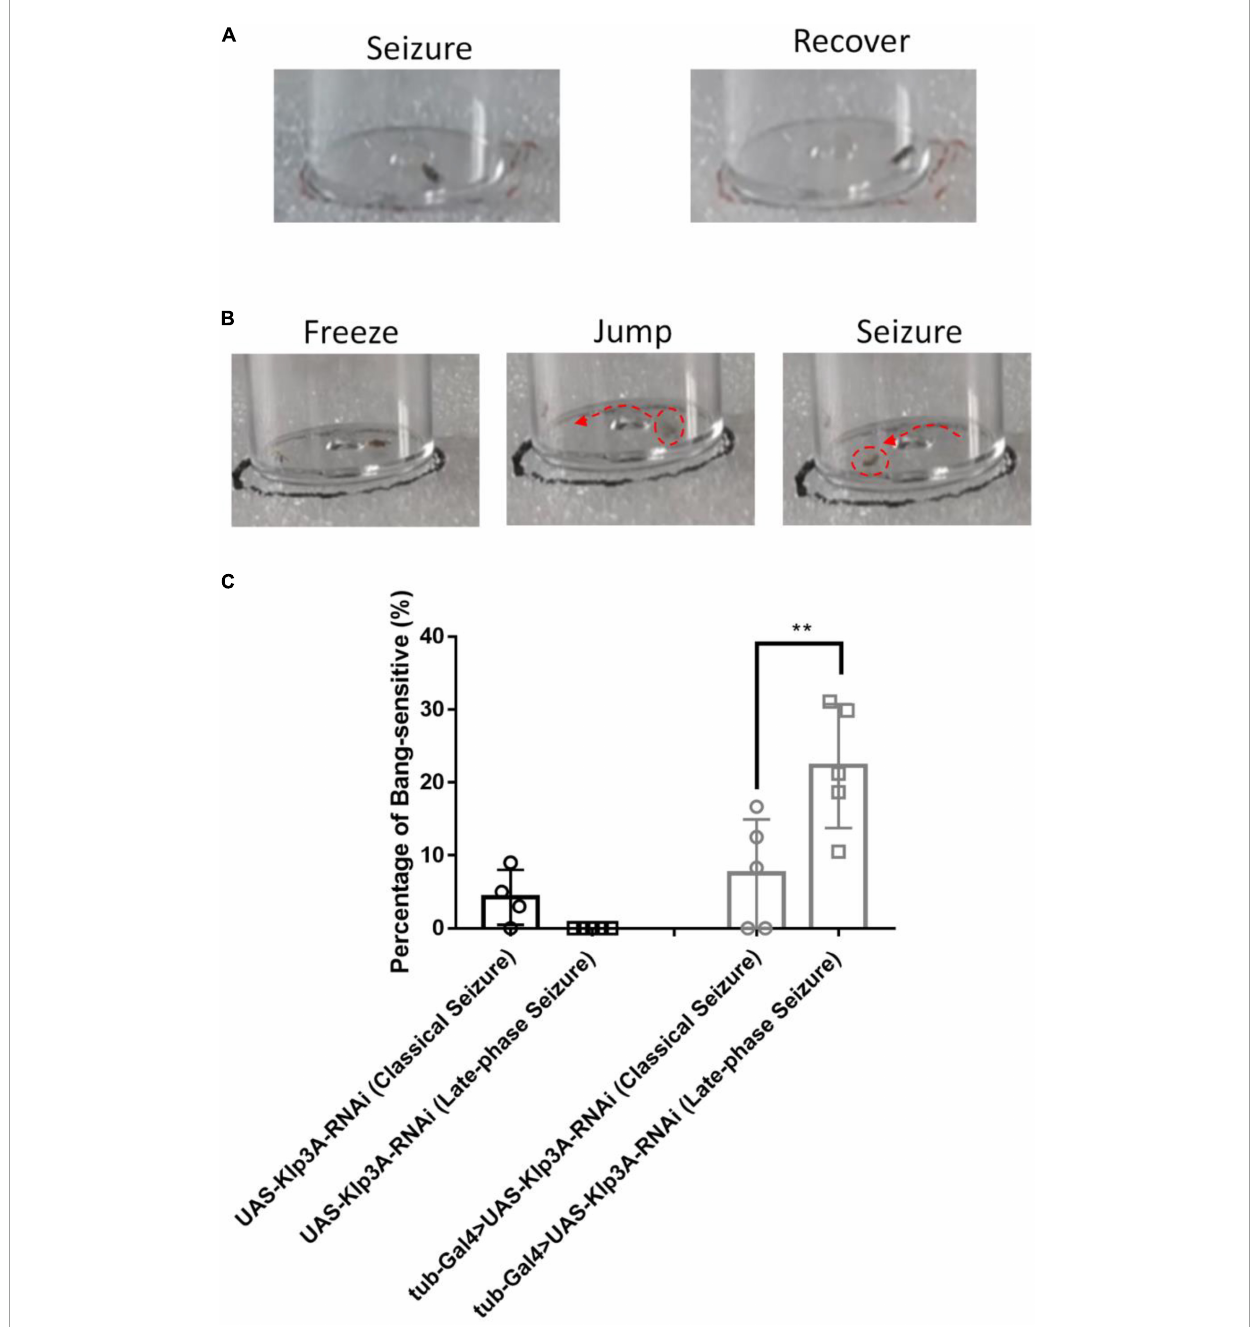
FIGURE2 Late-phase seizure behavior is shown in Klp3A knockdown flies. (A) The flies showed seizure behavior immediately in classical seizure behavior. (B) Late-phase seizure behavior contained the freezing stage and jumping stage before seizure behavior. (C) Klp3A showed a higher rate in late-phase seizures than that in classical seizures. One-way ANOVA, Tukey’s multiple comparison tests. ** P <